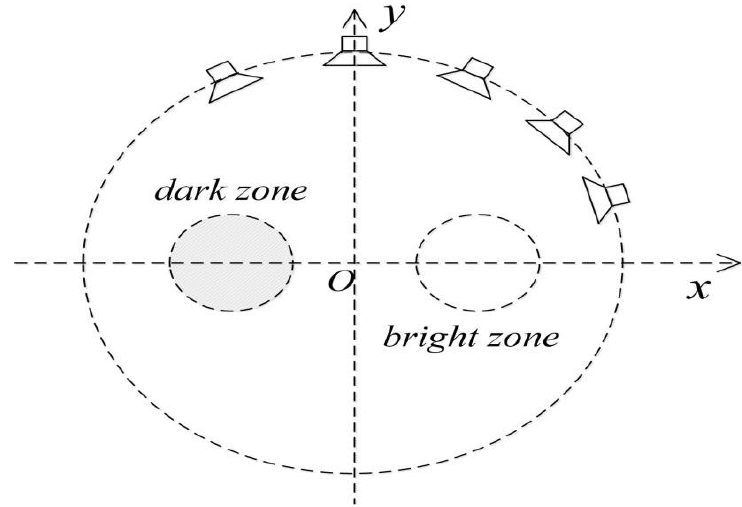
Figure 1. Loudspeaker array, bright zone and dark zone.